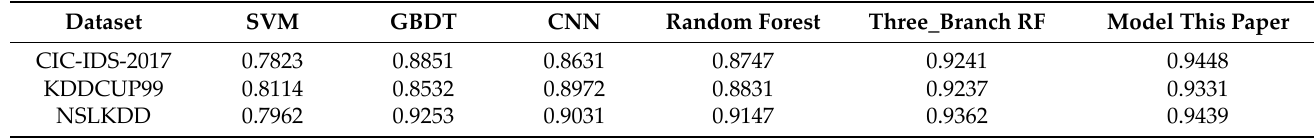
Table 7. F1 score index of the model on the experimental